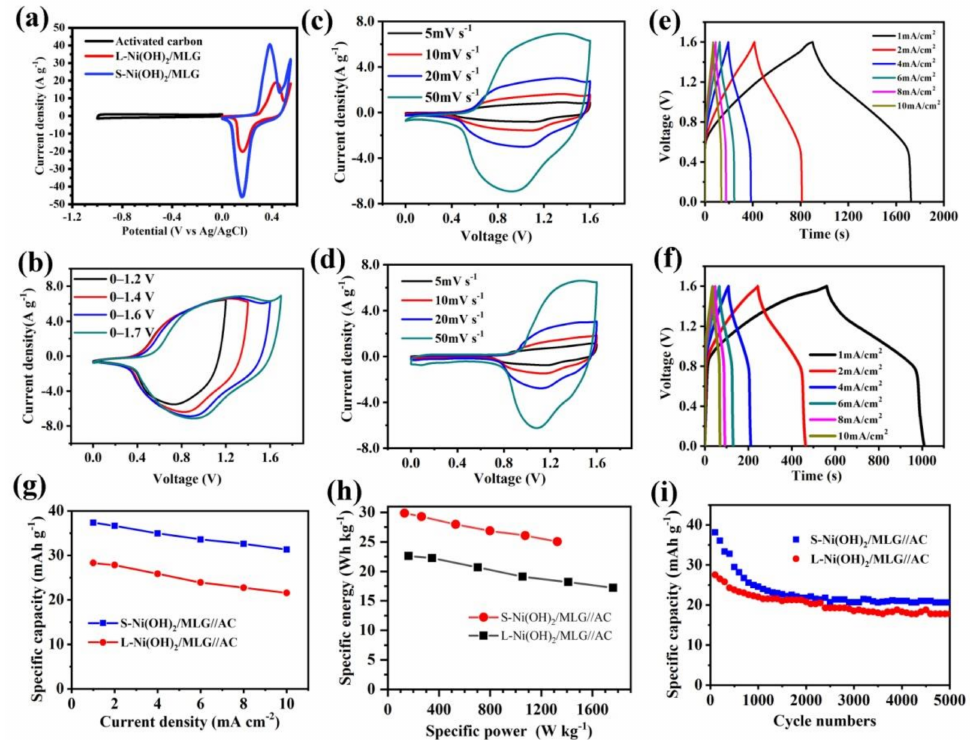
Figure 8. CV curves of S-Ni(OH) 2 /MLG, L-Ni(OH) 2 /MLG and activated carbon (AC) electrodes at a scan rate of 10 mV s − 1 ( a ), CV curves of S-Ni(OH) 2 /MLG//AC with different voltage scan ranges ( b ), CV curves of S-Ni(OH) 2 /MLG//AC ( c ) and L-Ni(OH) 2 /MLG//AC ( d ) at different scan rates, GCD curves of S-Ni(OH) 2 /MLG//AC ( e ) and L-Ni(OH) 2 /MLG//AC ( f ), Rate performance ( g ), Ragone plot ( h ) and cycling performance ( i ) of S-Ni(OH) 2 /MLG//AC and L-Ni(OH) 2 /MLG//AC. CV curves with different voltage scan ranges for the S-Ni(OH) 2 /MLG//AC capacitor were obtained at the scan rate of 50 mVs − 1 and shown in Figure 8b. The results show that the hybrid supercapacitor undergoes the similar redox processes under different voltage scan ranges. It indicates the high reversibility of the redox reactions. Different scan